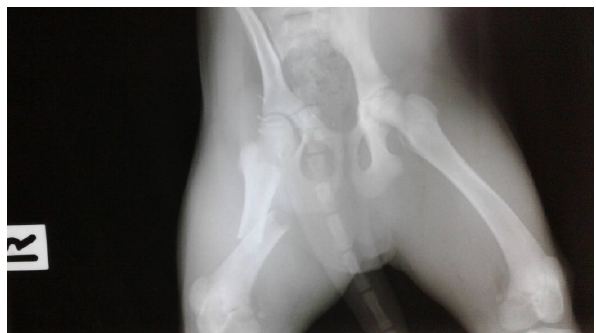
Fig. 9. Radiography in young dog showed transverse frac- ture of femur